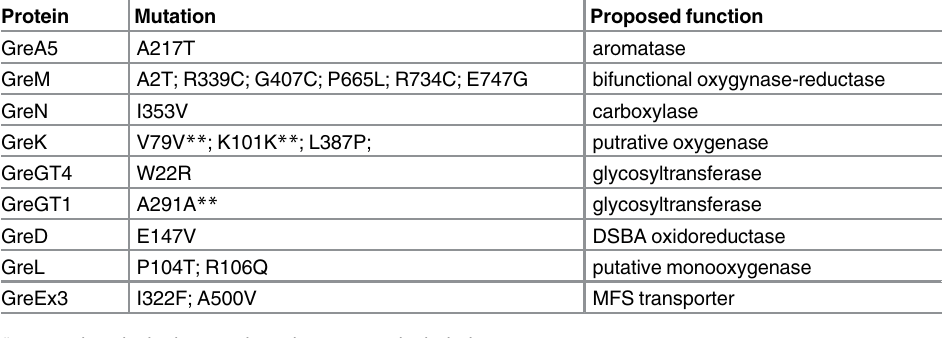
* — mutations in the intergenic regions are not